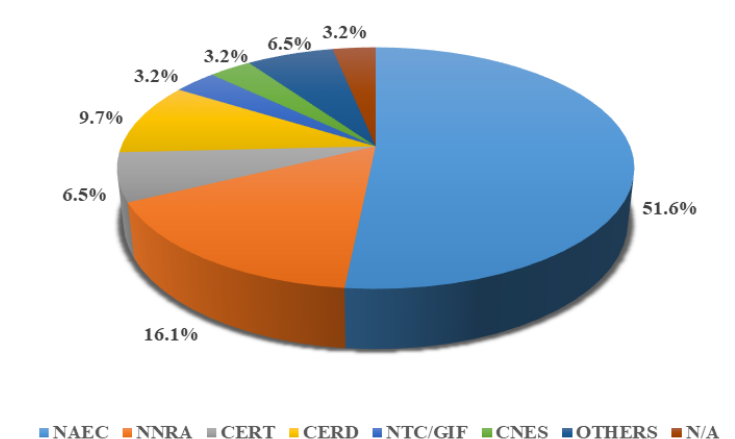
Figure 5. Survey response by Nigerian